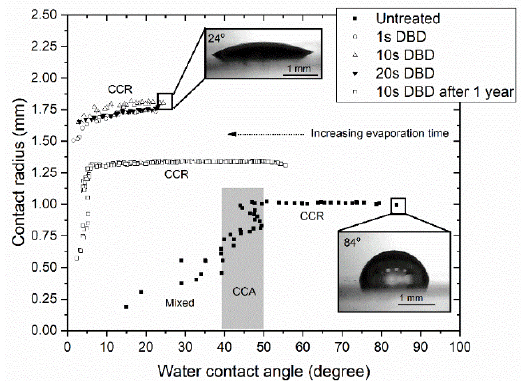
Figure 6. Dynamics of the water droplet drying expressed as the dependence of the contact radius on the water contact angle.